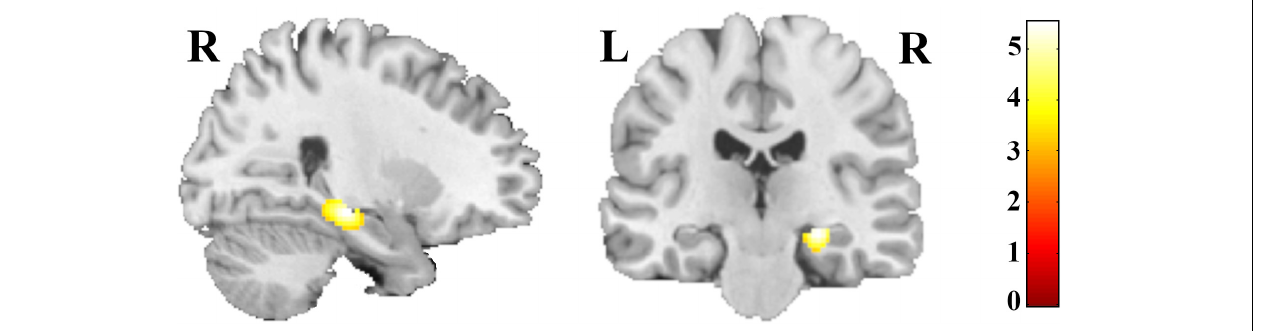
birth ( Figure 2 ). Finally, summer-born subjects, independent of group showed lower hippocampal volume compared to winter- born